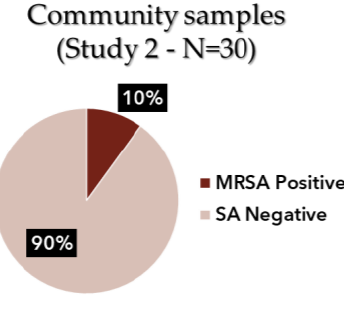
Figure 6. MRSA distribution in the control groups .